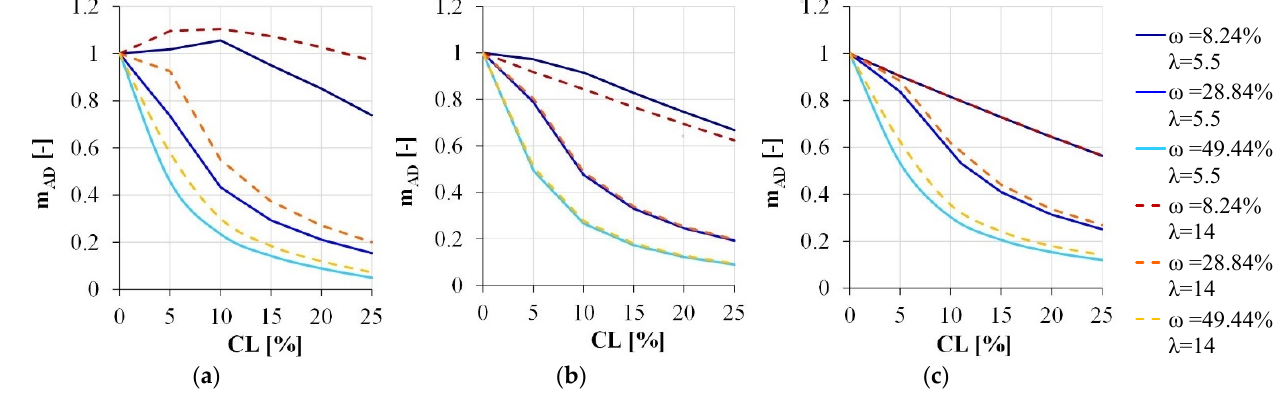
Figure 4. Load ‐ carrying capacity reduction due to the corrosion degradation: ( a ) ν = 25.65%, ( b ) ν = 15.39%, ( c ) ν = 5.13%.